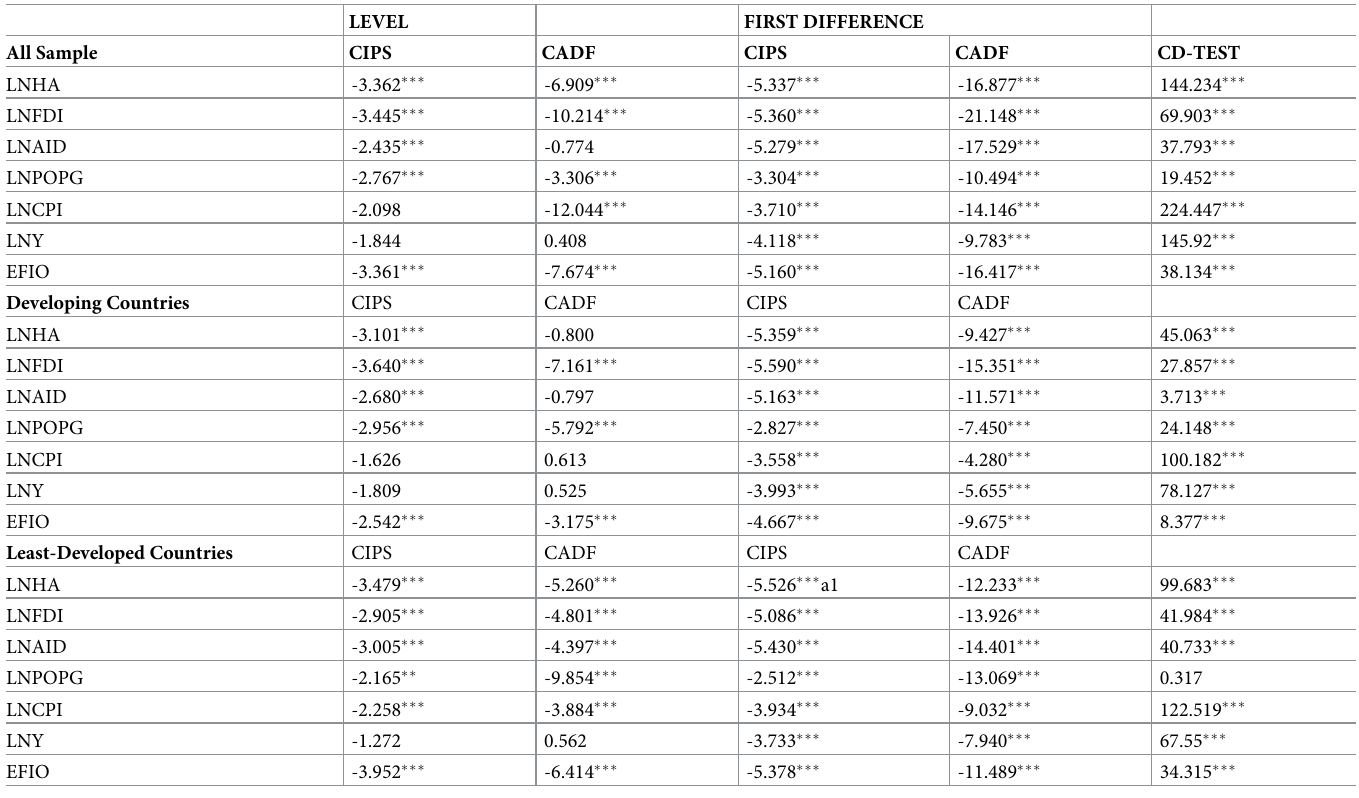
Table 3. Panel unit root test (Source: Authors’ construct). LEVEL FIRST